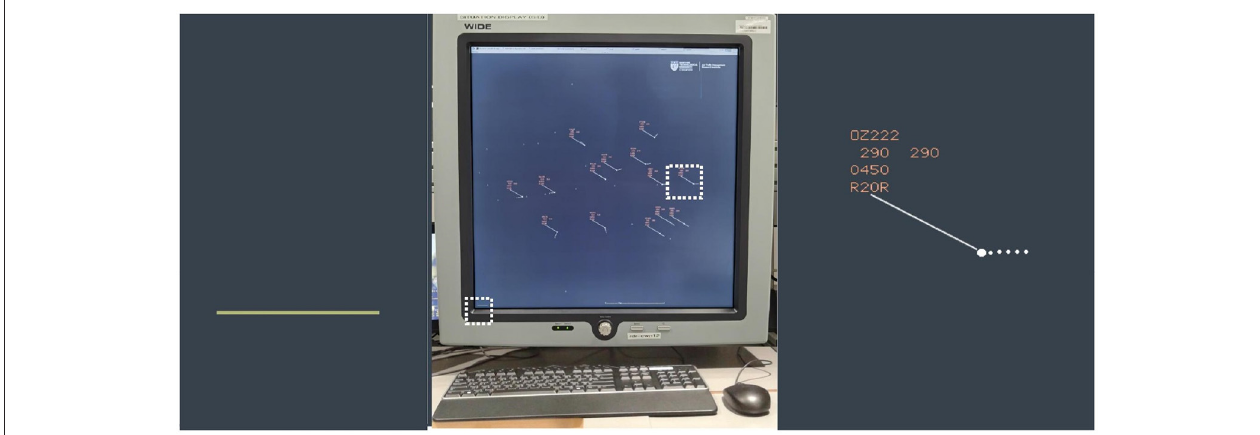
FIGURE 3 | 2K radar monitor (2,048 pixels × 2,048 pixels) used for showing simulated air traffic data. The air traffic scenario shown was taken from the third air traffic conflict detection test trial—the first high air traffic density (ATD) condition with 14 aircraft. The left panel shows the 20 mm ruler (boxed on bottom left corner of the radar display) that indicates 5.0 nm separation between a pair of aircraft while the right panel shows details from an enlarged data block of an aircraft (boxed on the right side of the radar display) appearing in the eastern sector of the controlled airspace. The university logo and the full name of the research institute were displayed at the top right corner of the radar